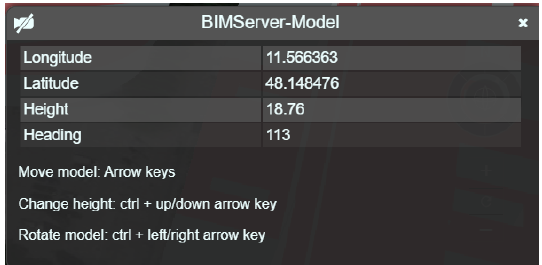
Figure 9: Attribute Display of the 3D web client with information about the glTF model